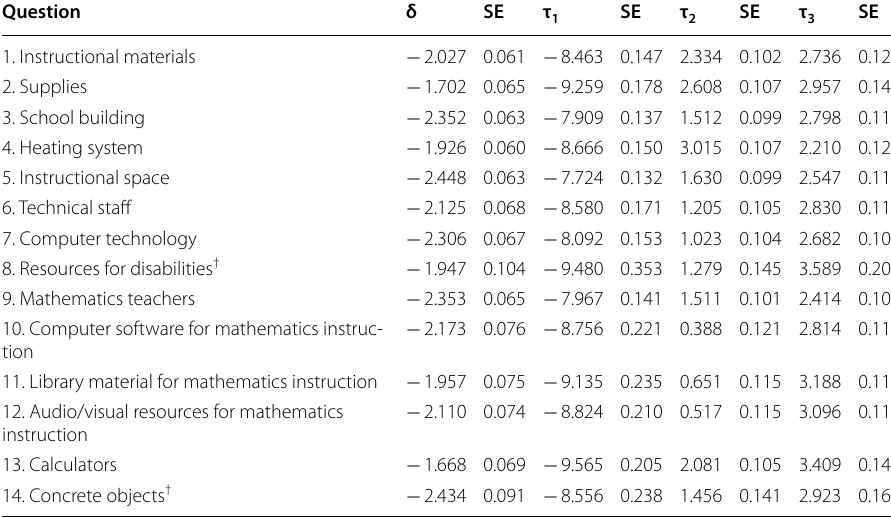
Table 8 Item parameter estimates for school resources availability